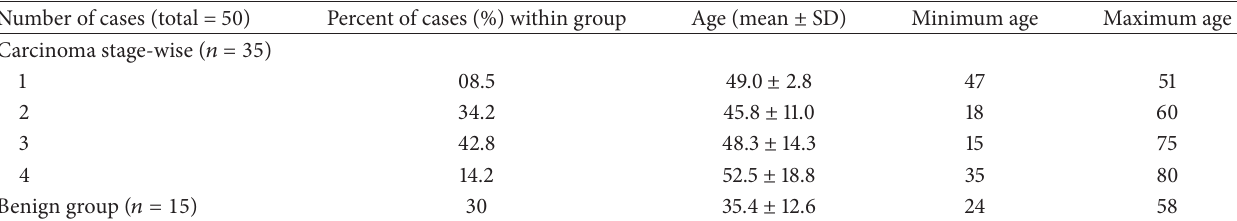
Table 1: Age-wise distribution of cases in different stages of carcinoma and benign group.